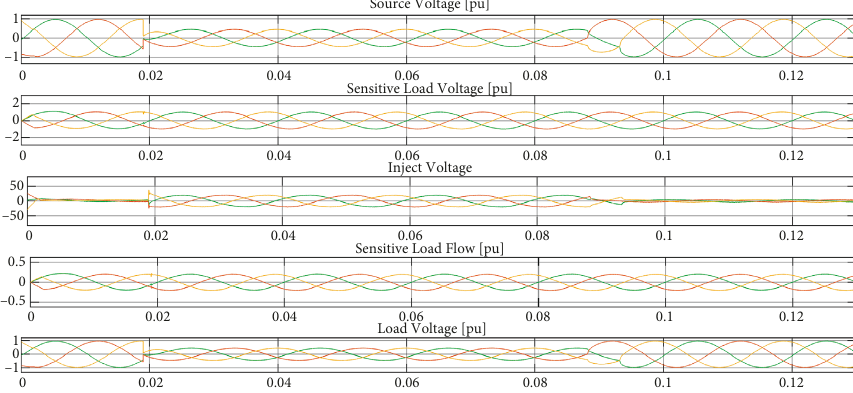
Figure 22: The result of compensating voltage sag in three-phase fault (by traditional